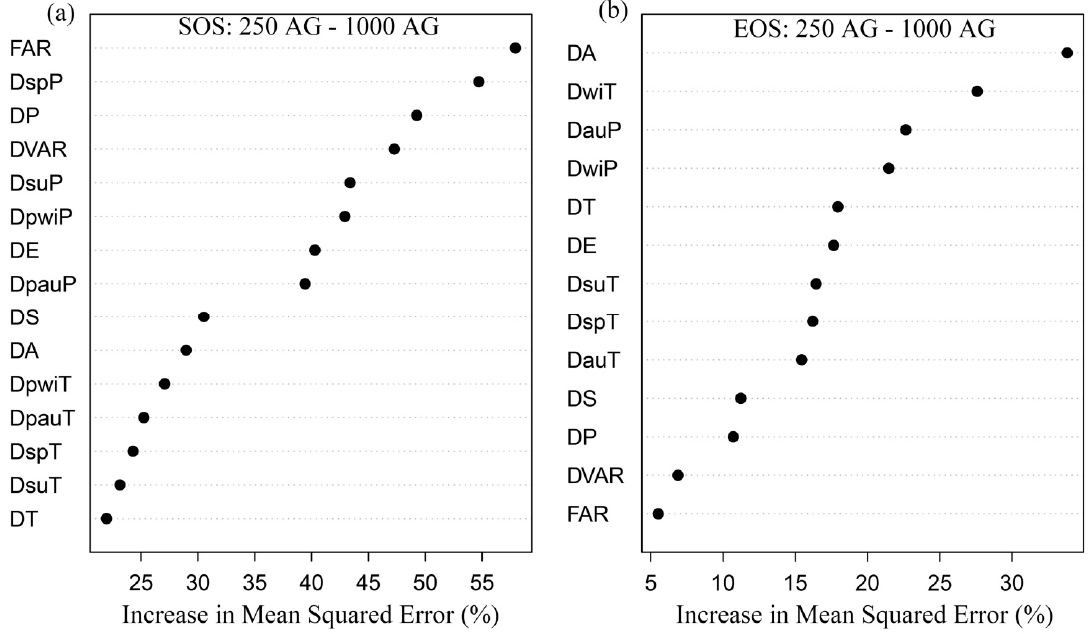
Figure 16. Relative importance of the factors affecting LSP spatial scale effect for ( a ) SOS spatial scale effect and ( b ) EOS spatial scale effect. effect and ( b ) EOS spatial scale